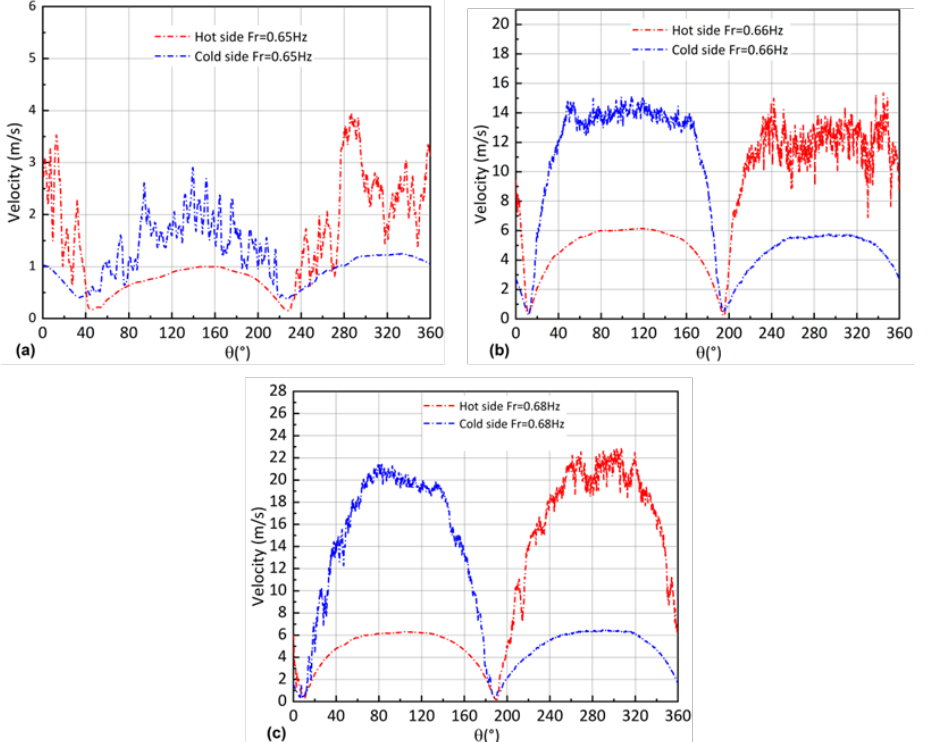
Figure 8. Evolution of velocities at hot and cold inlet sides of regenerator (( a ): Str_30%, ( b ): Str_35%, ( c ): Str_40%. L 1 = 60 mm, C 1 = 64.4 mm) versus phase for temperature gradient Δ T 1 = 70 °C/10 °C.